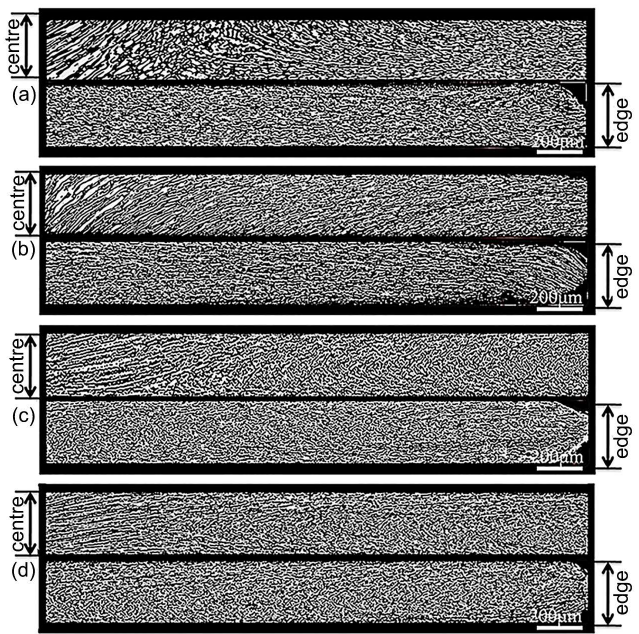
Figure 3. OM images of longitudinal sections from the center (on left) to the edge (on right) with different numbers of HPT revolutions after ( a ) 1/4, ( b ) 1/2, ( c ) 5 and ( d ) 20